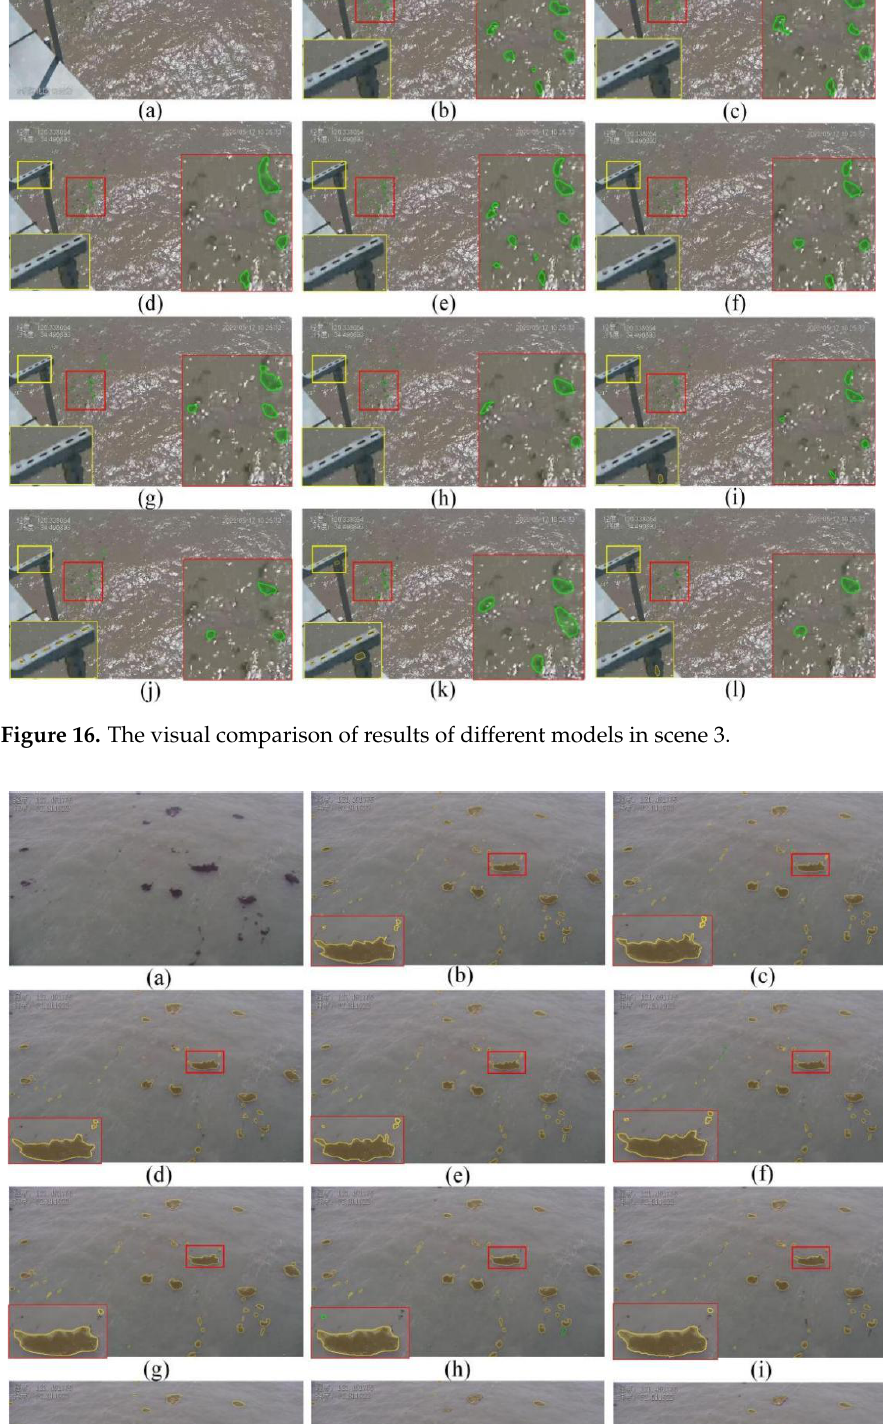
Figure 15. The visual comparison of results of different models in scene 2.